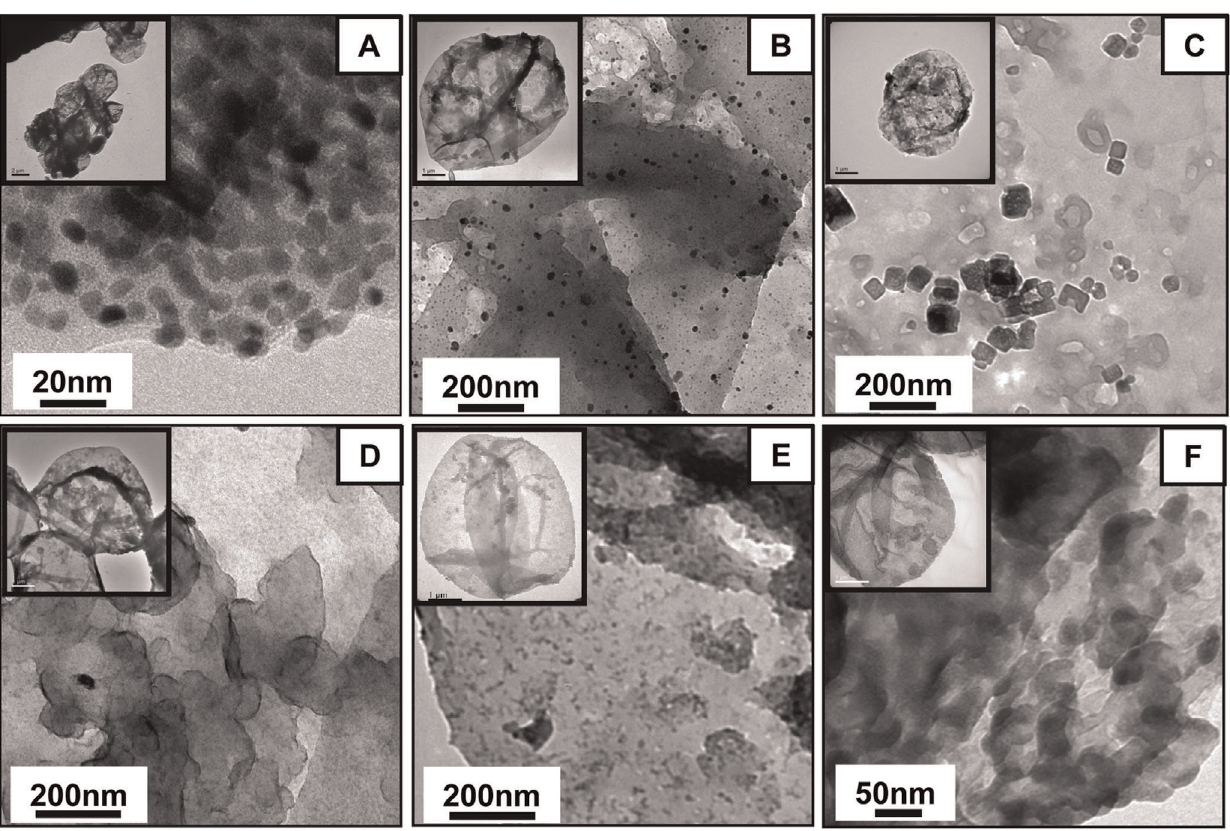
Figure 2. Validation of nanoparticle presence inside the PSS/PAH capsules. Representative TEM image of (a) Au, (b) Ag, (c) LaVO 4 :Eu 3 + (5%), (d) LaF 3 :Tb 3 + (5%), (e) CdS, and (f) GdF 3 :Tb 3 + (5%) nanoparticles-loaded PSS/PAH capsules. (Inset in each figure shows the respective nanoparticles- loaded PSS/PAH capsule at lower magnification.).